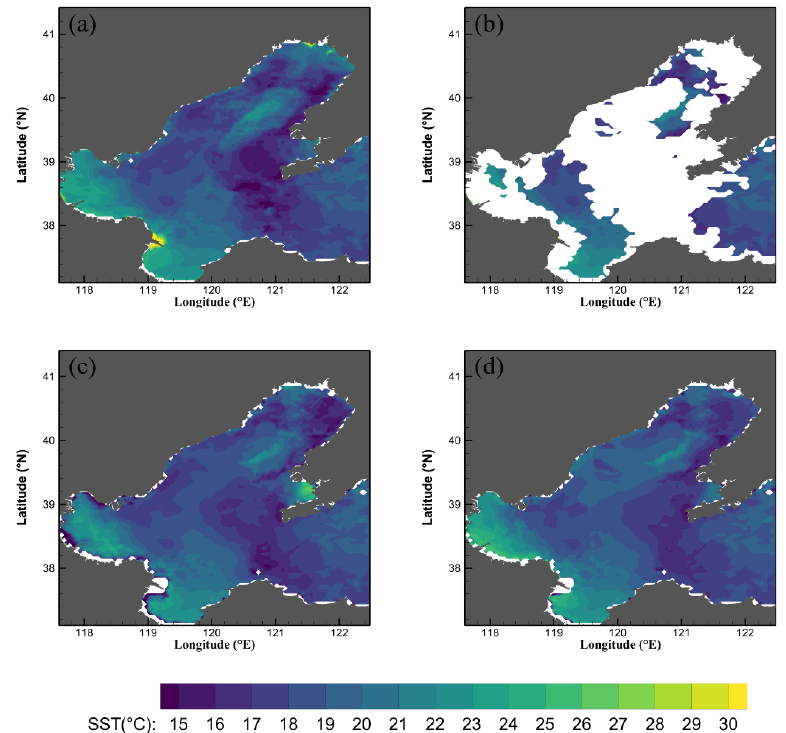
Figure 9. ( a ) Original SST missing data in Jun. 2013, ( b ) Constructed SST missing data according to chl-a, ( c ) Reconstructed SST data using DINEOF, and ( d ) Reconstructed SST data using IV − DINEOF.